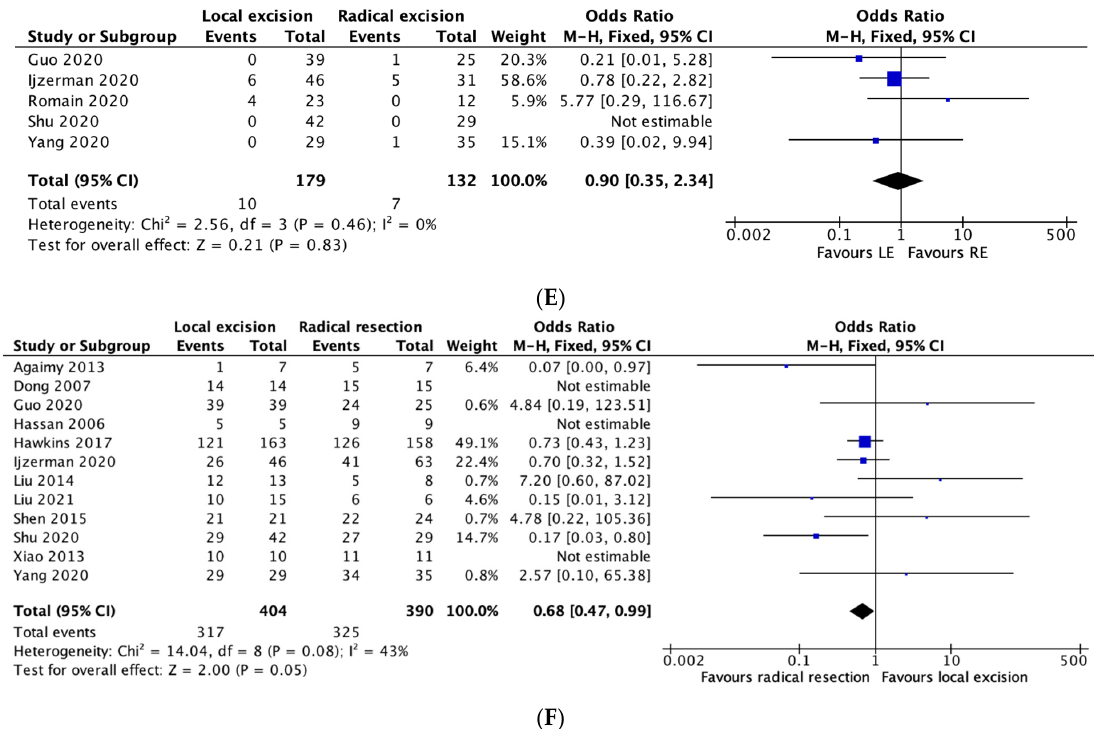
Figure 2. ( A – F ): Local excision vs. radical excision meta-analysis results. ( A ) Recurrence, ( B ) Five- year Overall Survival, ( C ) Five-year Disease-free Survival, ( D ) Length of Stay, ( E ) Intraoperative Tumour Perforation, ( F ) R0 Rates